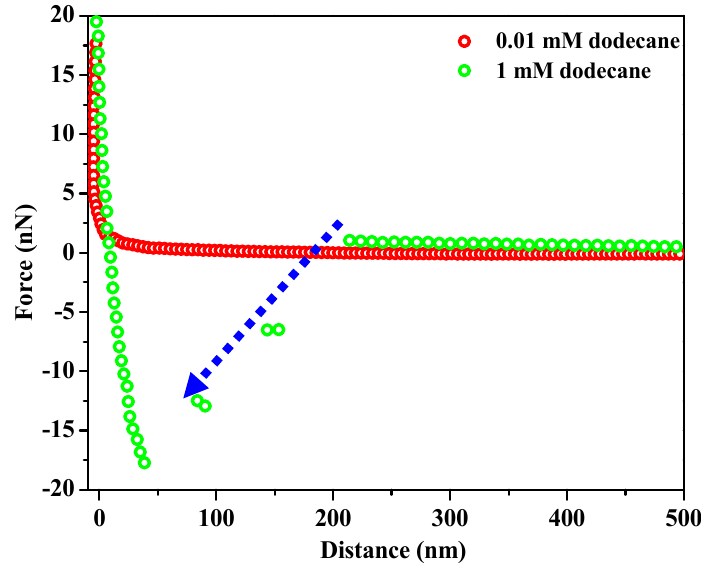
Figure 8. Force between PMMA colloid probe and oxidized PG in presence of dodecane. Only approach force curves were shown.